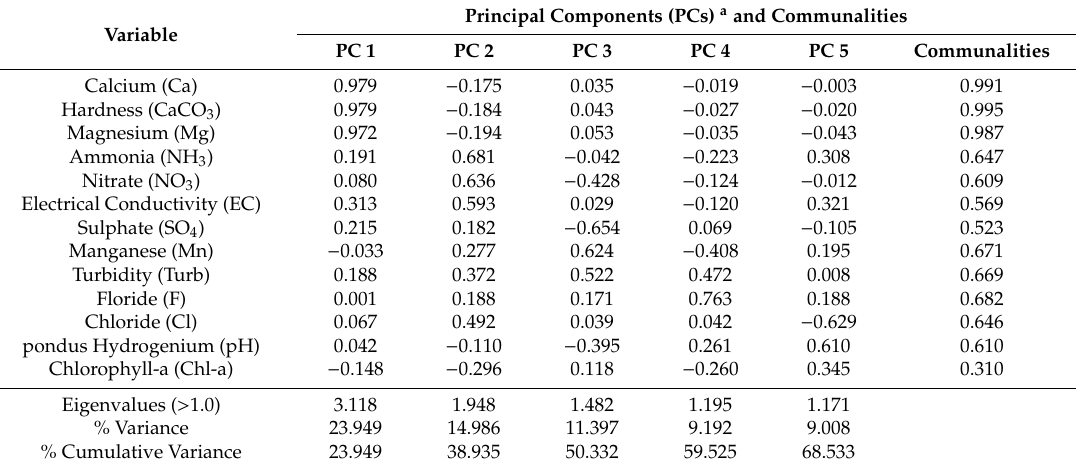
Table 5. Principal Component Analysis Vector of Coe ffi cients for First Five Principal Components (PCs) with Eigenvalues Greater Than One ( > 1.0) for Umgeni Water Quality Data.